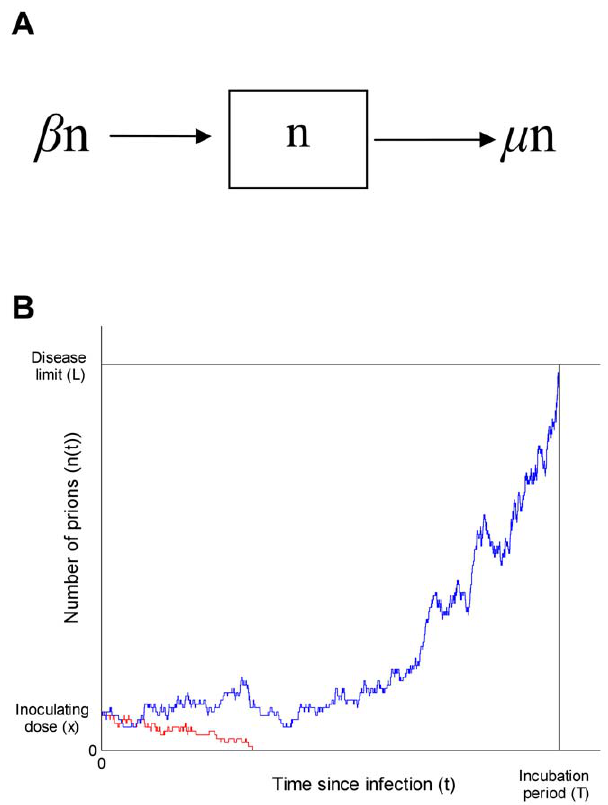
Figure 2. A stochastic model of prion replication. A) A mathematical model of prion replication in which the number of prions ( n ) changes according to a stochastic birth-death process. Prions are ‘born’ at rate b per prion and ‘die’ at m per prion. B) In the model the onset of disease occurs once the number of prions reaches a predetermined ‘disease limit’ ( L ). An example of exponential prion growth up to the disease limit is shown by the blue line. Alternatively, by chance, the prion population can also become extinct and the host is left uninfected (red line). For both of these examples the same initial dose and model parameters are used. This model of a stochastic birth- death process with two absorbing barriers (at n(t)=0) and n(t)=L) is a well-studied problem called the ‘Gambler Ruin’